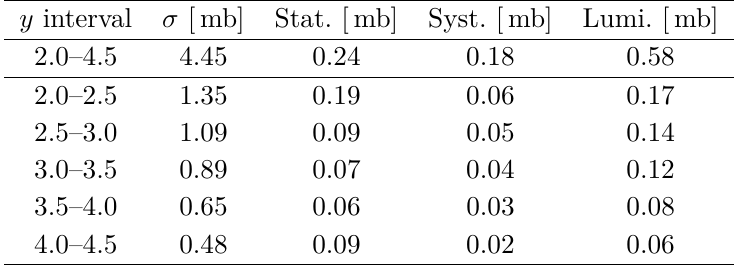
Table 3 . Measured cross-section σ with breakdown of statistical, systematic and luminosity uncer- tainties measured as a function of the J/ψ rapidity. Note that the cross-sections are not normalised by the y interval